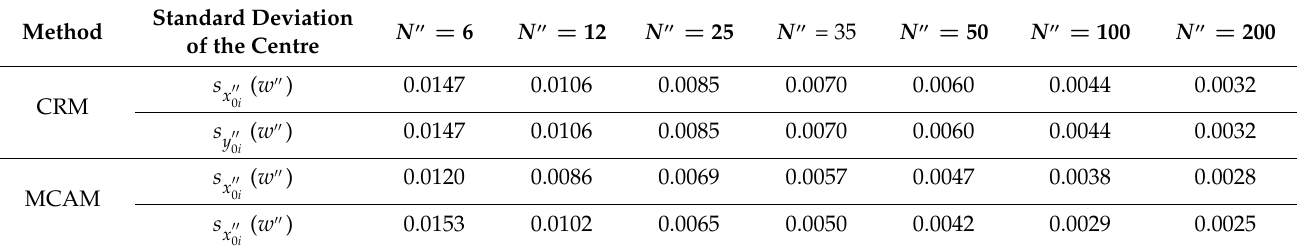
Table 3. Standard deviations at different line numbers N ” ( i best = 9).